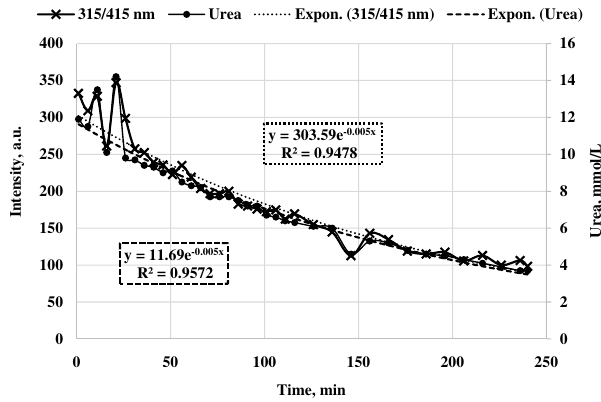
Fig. 6. Time evolution of a dialysis procedure at a Fresenius 5008 CorDiax machine (¯lter FX 100). Fluorescence was mea- sured o®line at (cid:1) exc =(cid:1) em ¼ 315 = 415